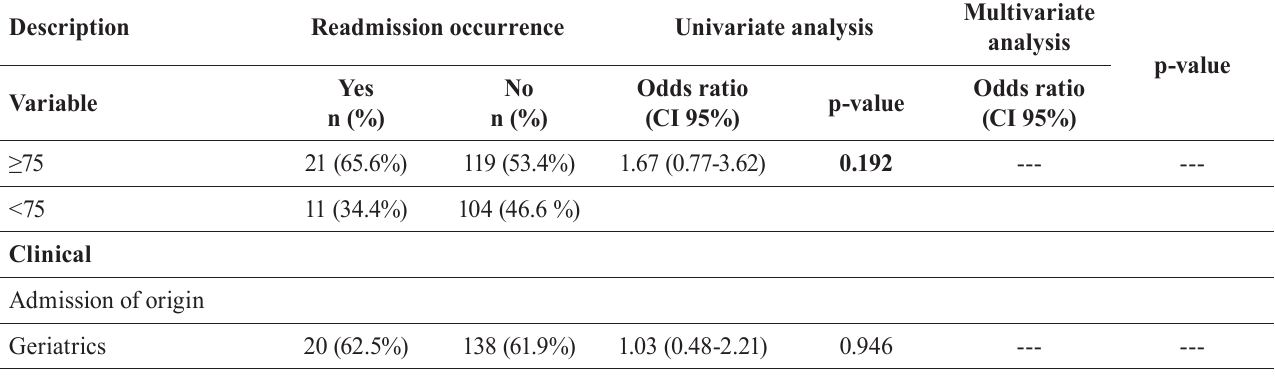
TABLE II – Univariate and multivariate analysis of the factors associated with the occurrence of readmission of older adults